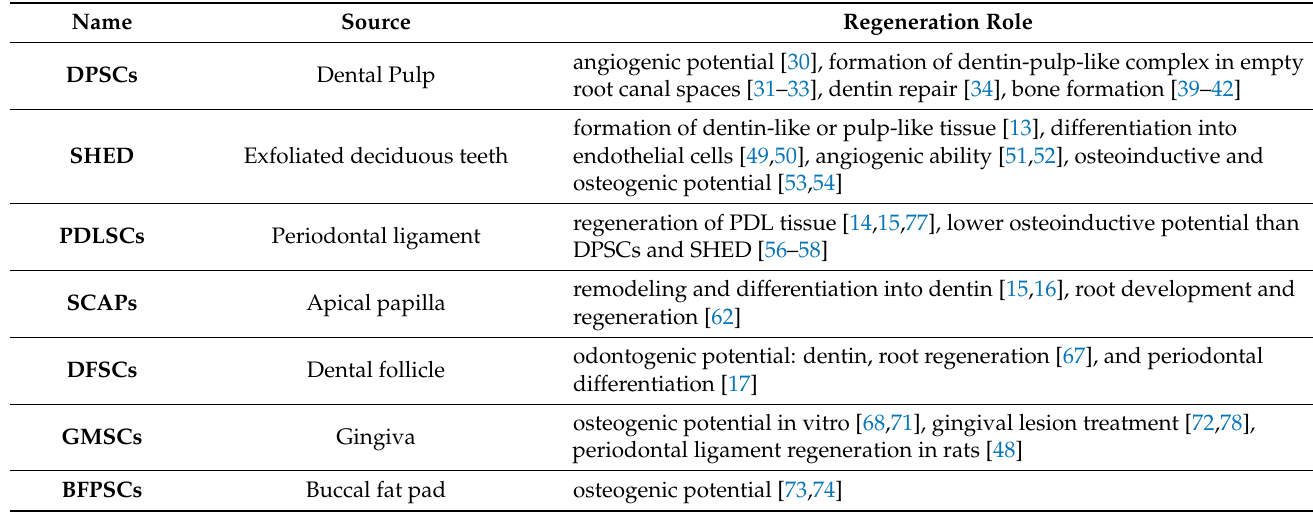
Table 1. Source and main activities of oral cavity-derived